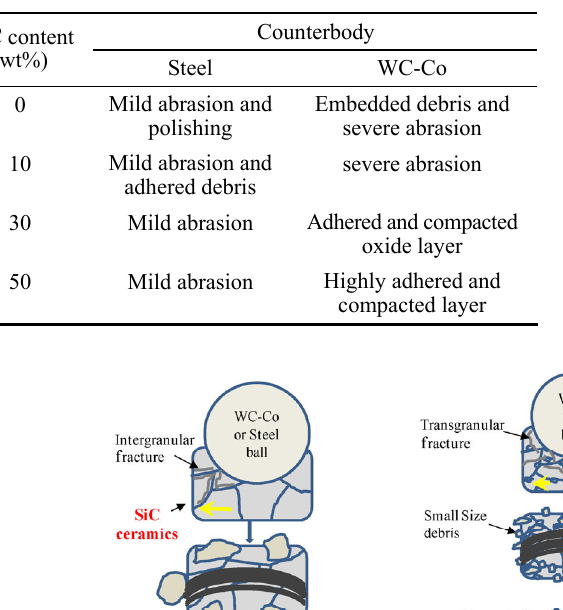
Table 3. A schematic illustration of major material Table 3 Wear types for the SiC-WC composites against WC-Co and steel ball as function of WC content.